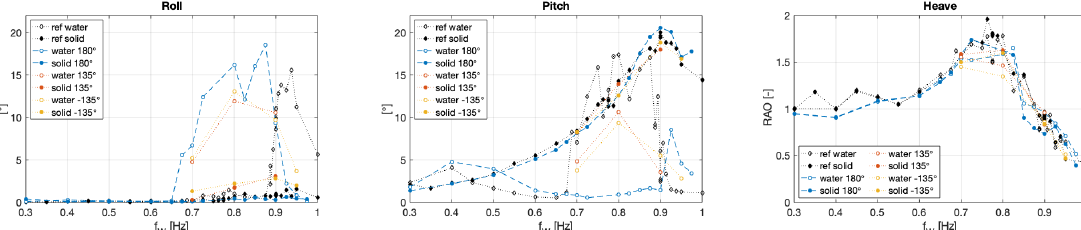
Figure 12. Roll, pitch and heave response for the wave directions 180 ◦ and ± 135 ◦ compared for the